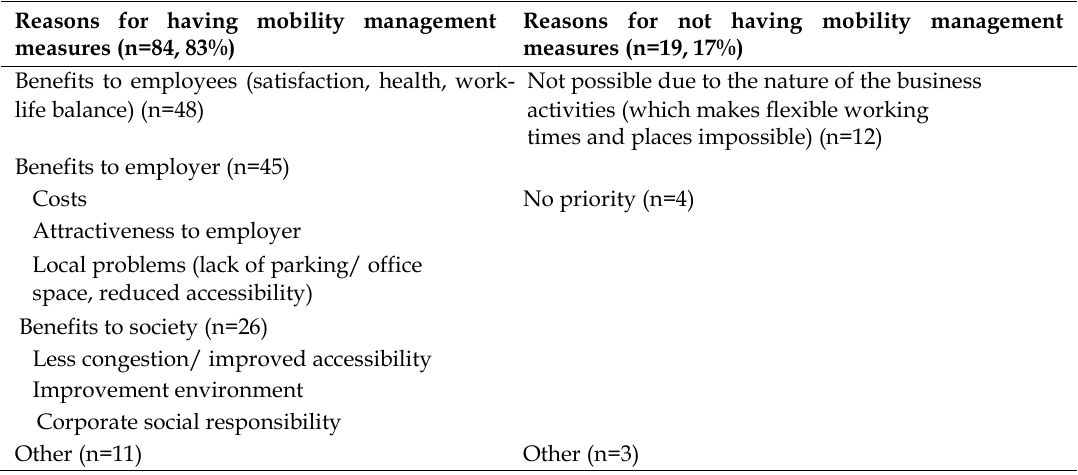
Table 2. Reasons for having implemented and for not having implemented mobility management